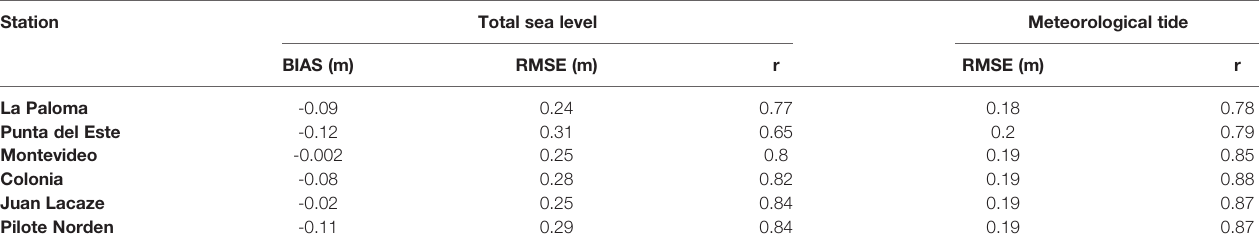
TABLE 5 | Stadistics obtained comparing modeled total sea level (BIAS, RMSE and r) and meteorological tide (RMSE and r) with measures in La Paloma, Punta del Este, Montevideo, Colonia, Juan Lacaze and Pilote Norden.